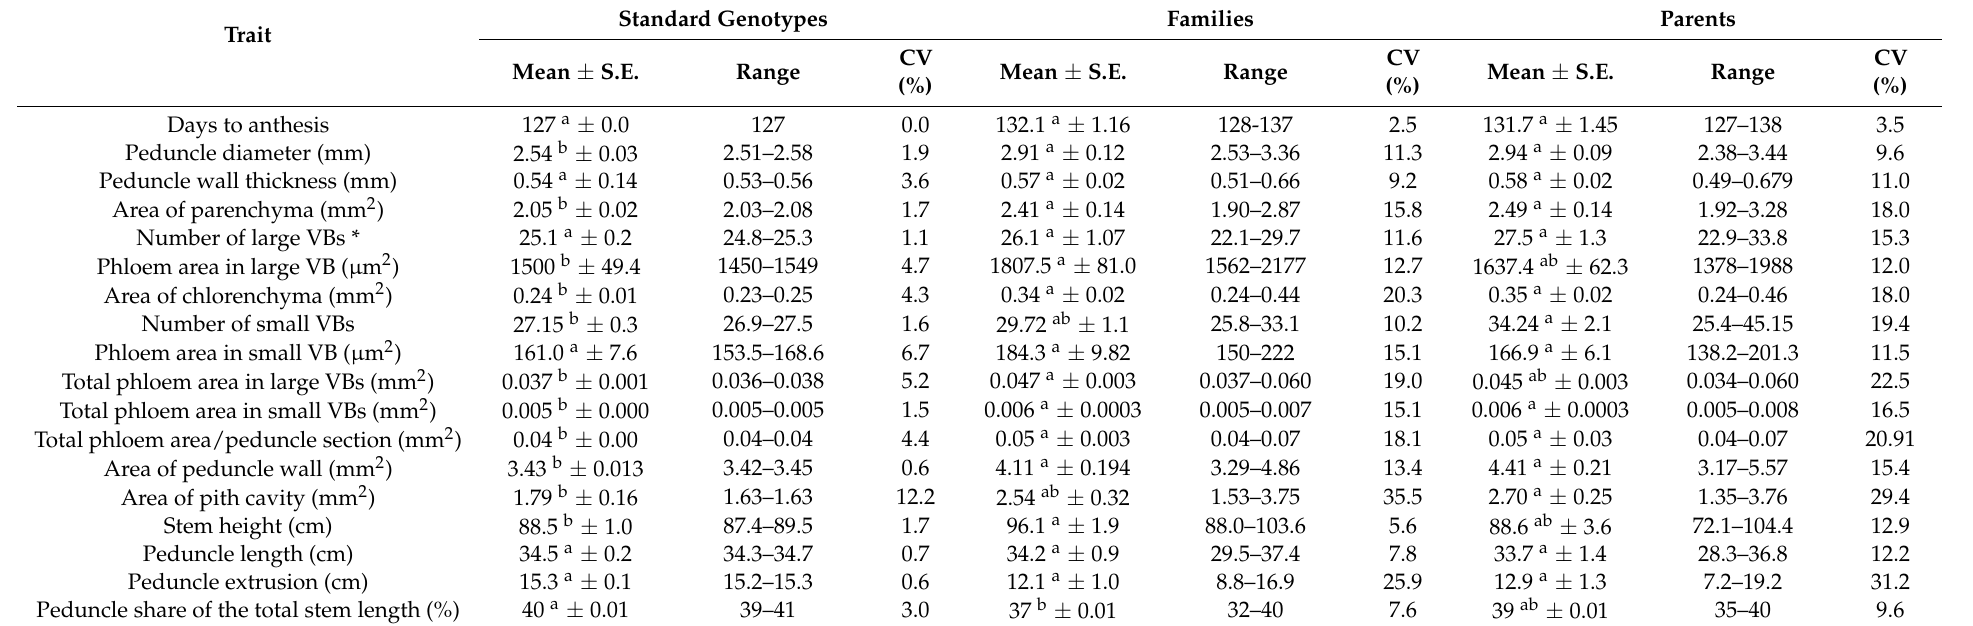
Table 3. Descriptive statistics for stem height and peduncle morpho-anatomical traits for 20 common wheat genotypes—standards, F6:7 families, and parent genotypes used to make the F6:7 families. Data represent mean values for two growing